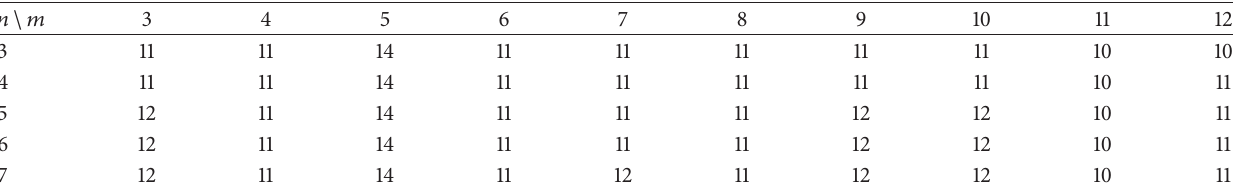
Table 1: Values of 𝜆(𝑃 𝑛 ⊠ 𝐶 𝑚 ) .